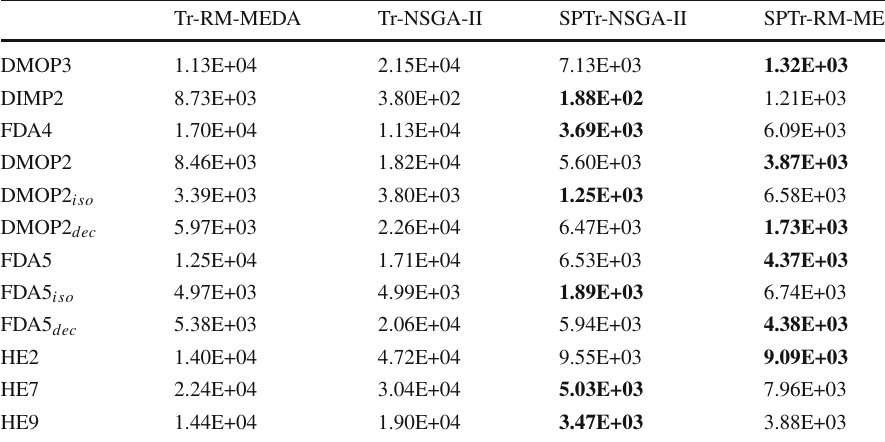
Table 5 The CPU running time of each